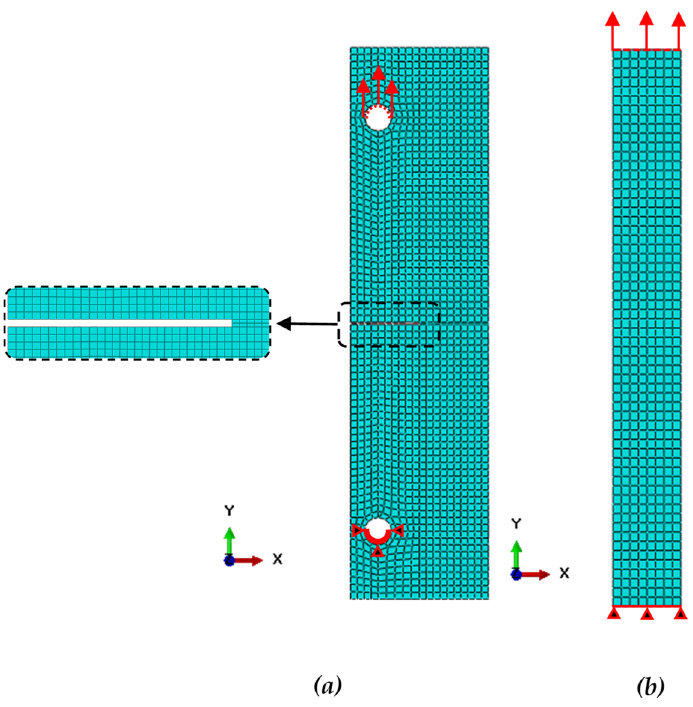
Figure 6. Mesh and boundary conditions of the present model, ( a ) ASTM E1922, and ( b ) ASTM D3039.